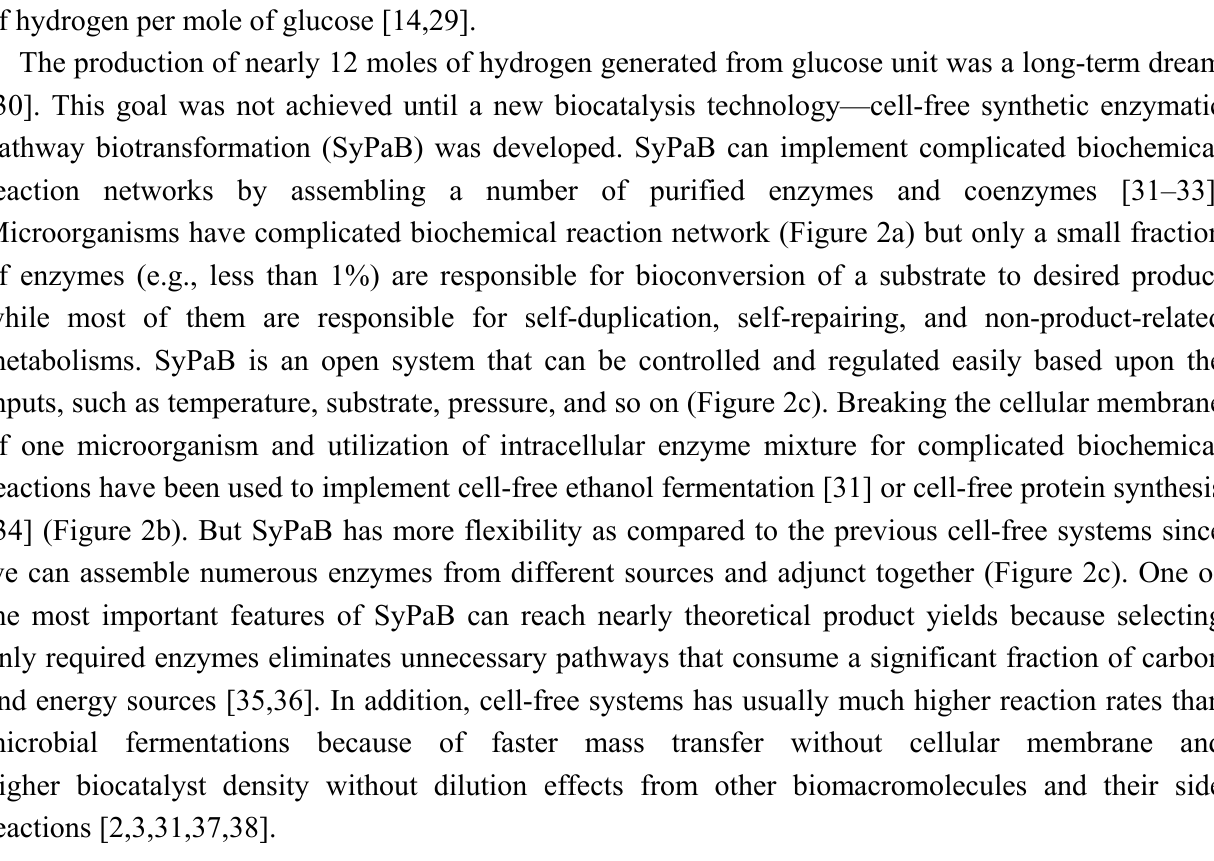
Figure 2. System complexity comparison of in vivo microbial fermentation ( a ), cell-free fermentation using the cell lysate from one organism by breaking its cellular membrane ( b ), and cell-free synthetic enzymatic pathway biotransformation that assembles the purified stable enzymes from different organisms ( c